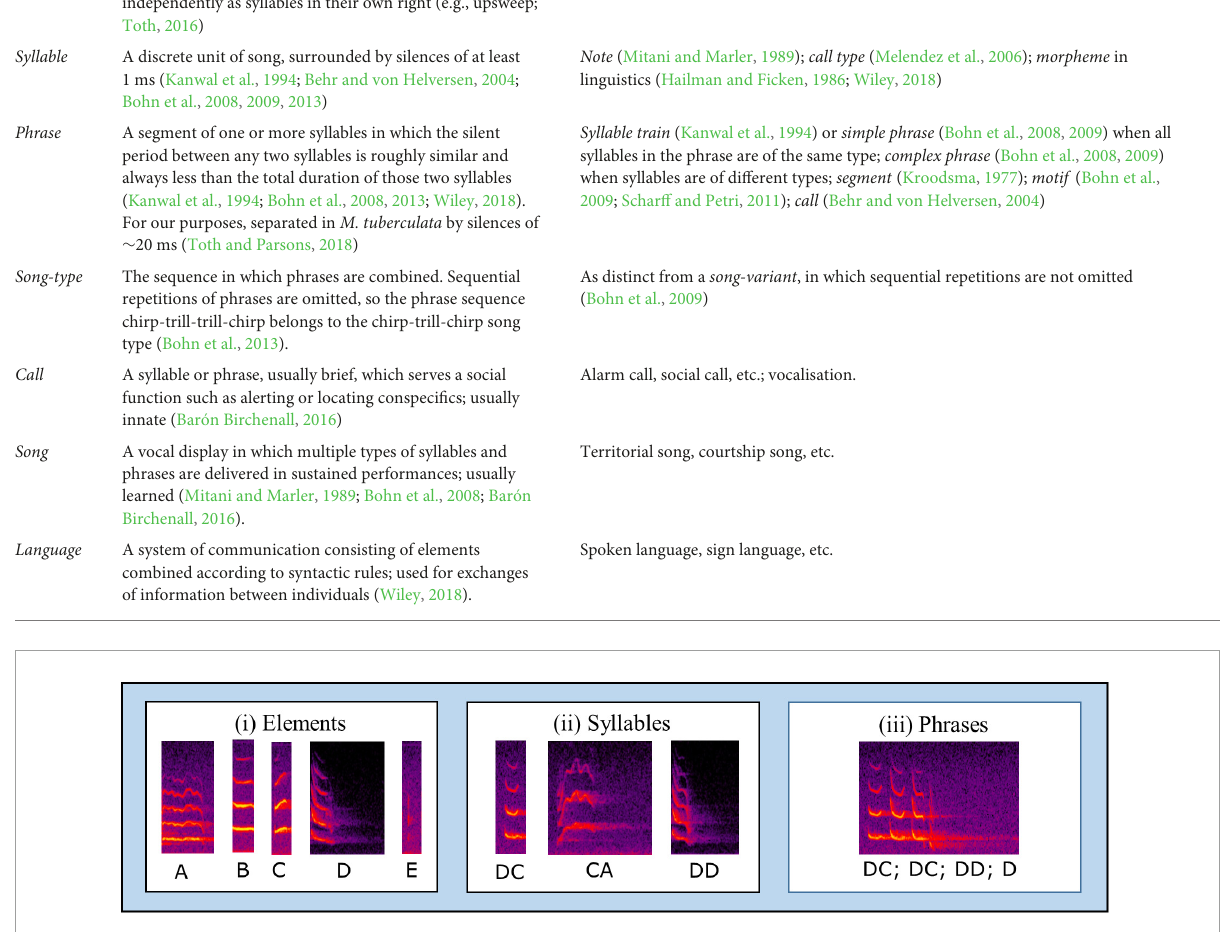
FIGURE1 The construction of Mystacina tuberculata song. There are five basic elements (i): trills (A), tones (B), upsweeps (C), downsweeps (D), and clicks (E). These can be combined in a variety of ways to form syllables (ii) such as “downsweep-upsweep” (DC), “upsweep-trill” (DA), or “downsweep-downsweep” (DD); elements may also stand alone as syllables in their own right. Syllables can be combined to make phrases (iii), such as “downsweep-upsweep; downsweep-upsweep; downsweep-downsweep; downsweep” (DC; DC; DD; D), though syllables may